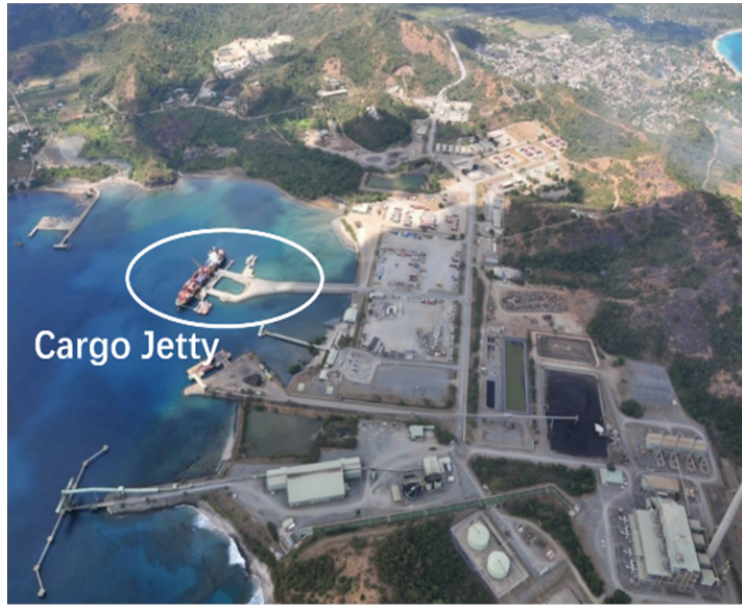
Figure 1. Overview of the studied B